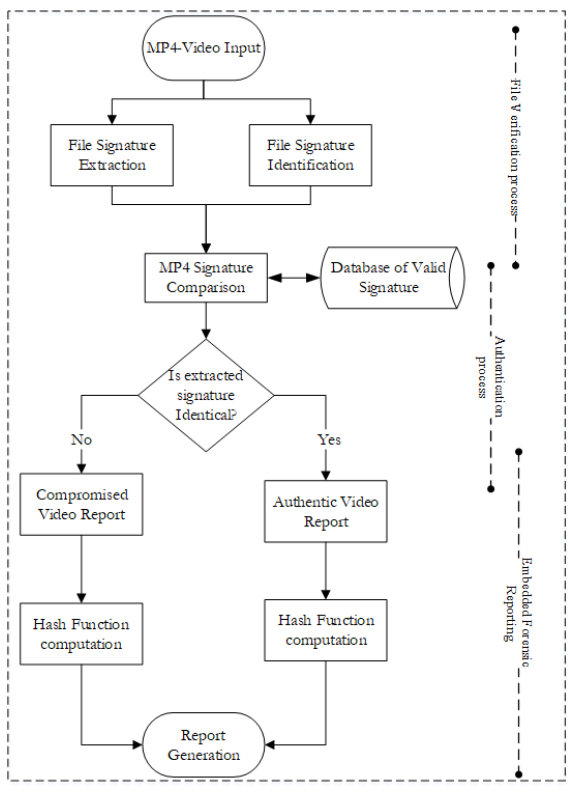
Figure 3. Operational